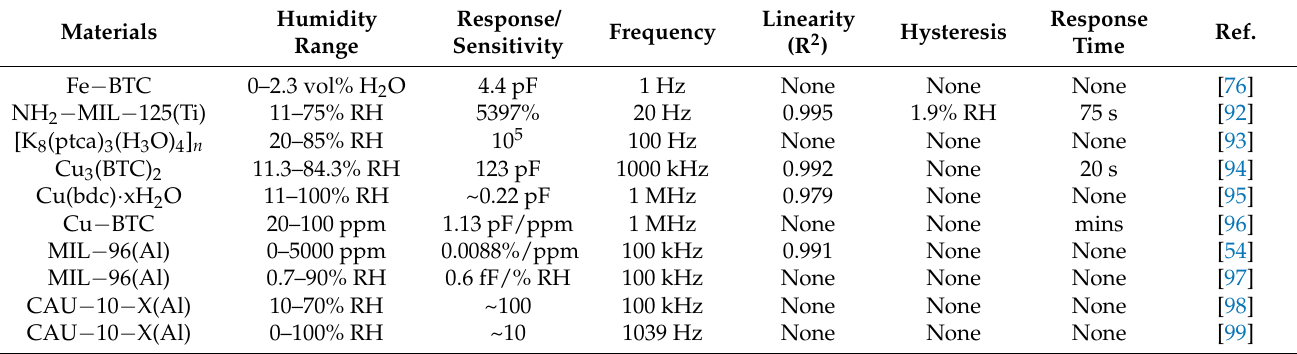
Table 2. Sensing properties of MOF − based capacitive − type humidity